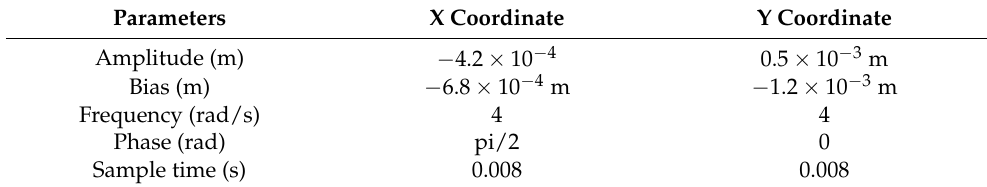
Table 3. Input signal parameters.